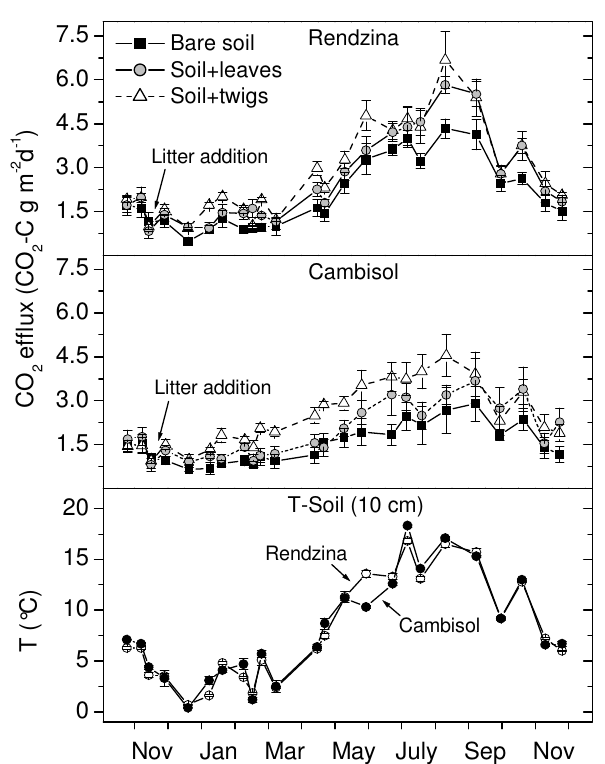
Fig. 2. Seasonal course of the soil CO 2 effluxes in the Rendzina and the Cambisol and of the soil temperature at a depth of 10cm. The values are the means of five replicates ± standard error.